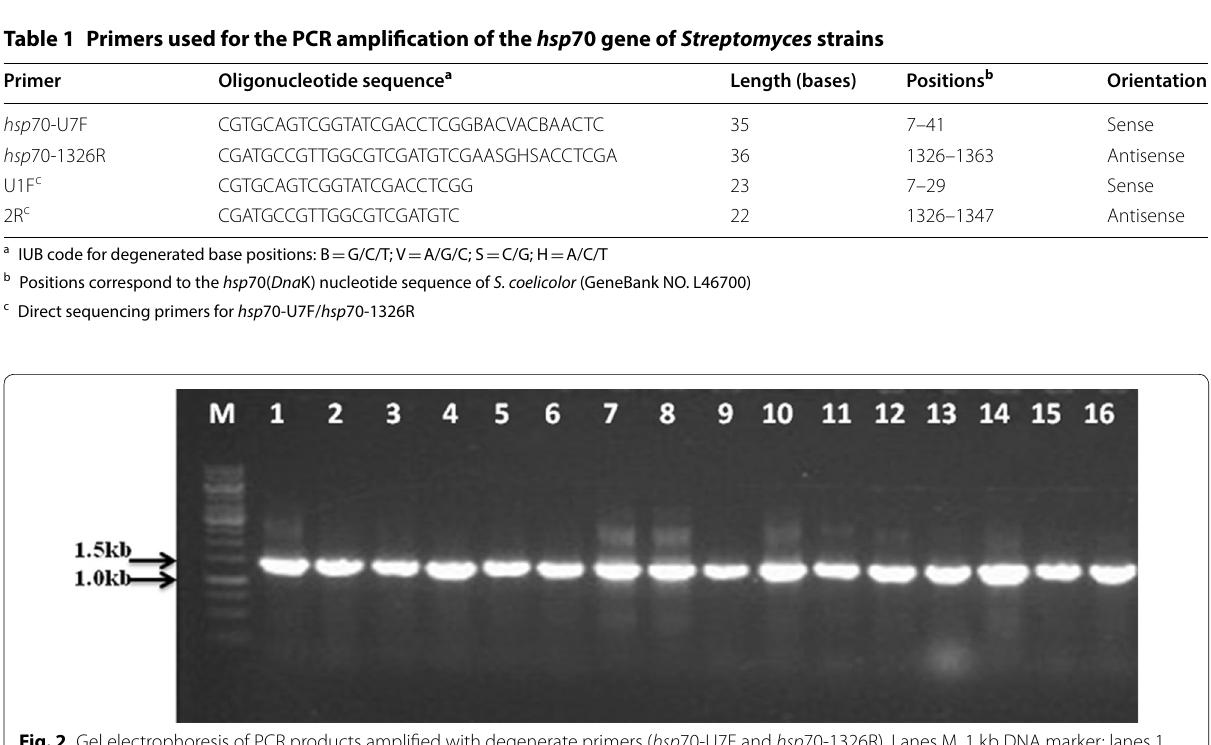
Fig. 2 Gel electrophoresis of PCR products amplified with degenerate primers ( hsp 70-U7F and hsp 70-1326R). Lanes M, 1 kb DNA marker; lanes 1 to 16, S. tendae strain 944, S. pluricolorescens strain 999, 1043 S. panayensis strain 1043, S. flavovariabilis strain 1067, S. macrosporeus strain 1076, S. drozdowiczii strain 1136, S. olivaceus strain 1137, S. chartreusis strain 1159, S. malaysiensis strain 1161, S. werraensis strain 1165, S. albogriseolus strain 1168, S. hawaiiensis strain 1183, S. castaneoglobisporus strain 1185, S. phaeofaciens strain 1187, S. acrimycini